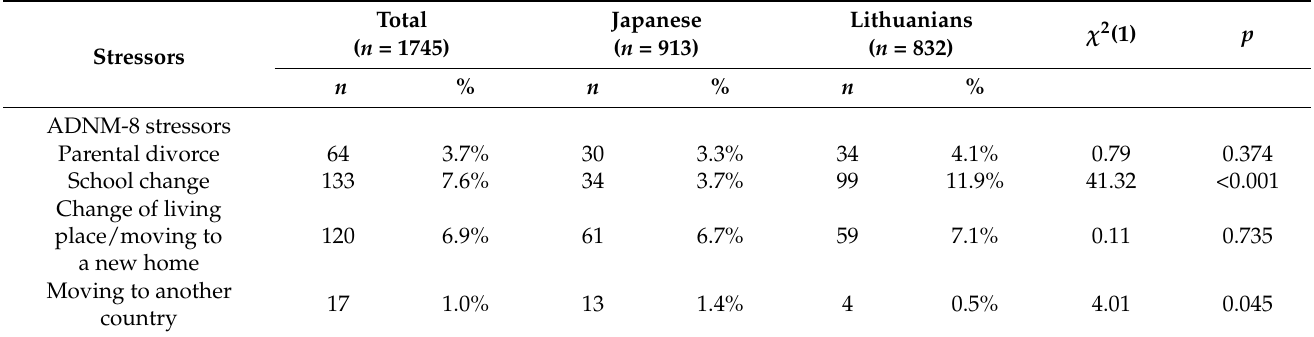
Table 2. Life stressors among Japanese and Lithuanian adolescents ( n =